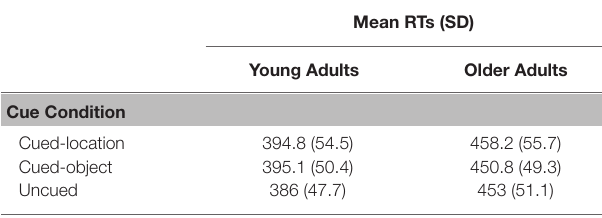
TABLE 2 | Mean reaction times and standard deviations for Experiment